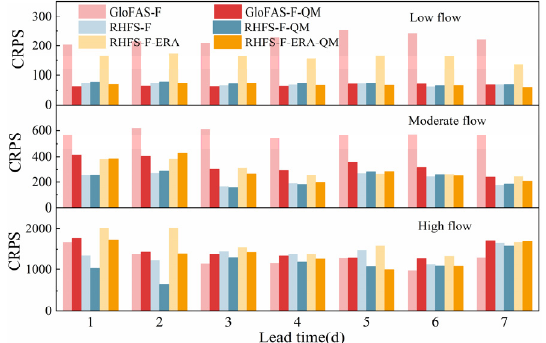
Figure 9. The mean CRPS of forecasts for low flow, moderate flow and high flow, respectively (defined by the 50th and 90th percentiles of the daily flow values), at lead times of 1–7 d, over the verification period (2007, 2008, June–October). CRPS = continuous ranked probability score.